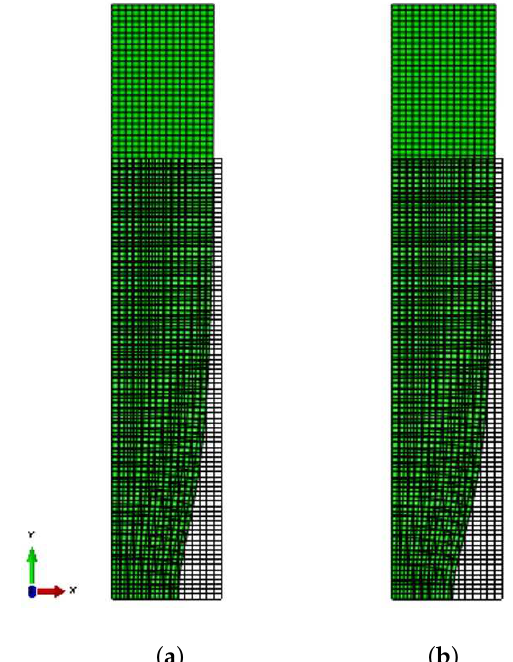
Figure 17. Deformed configurations for a nominal strain of 35%: ( a ) transforming, ( b ) “non-transforming”